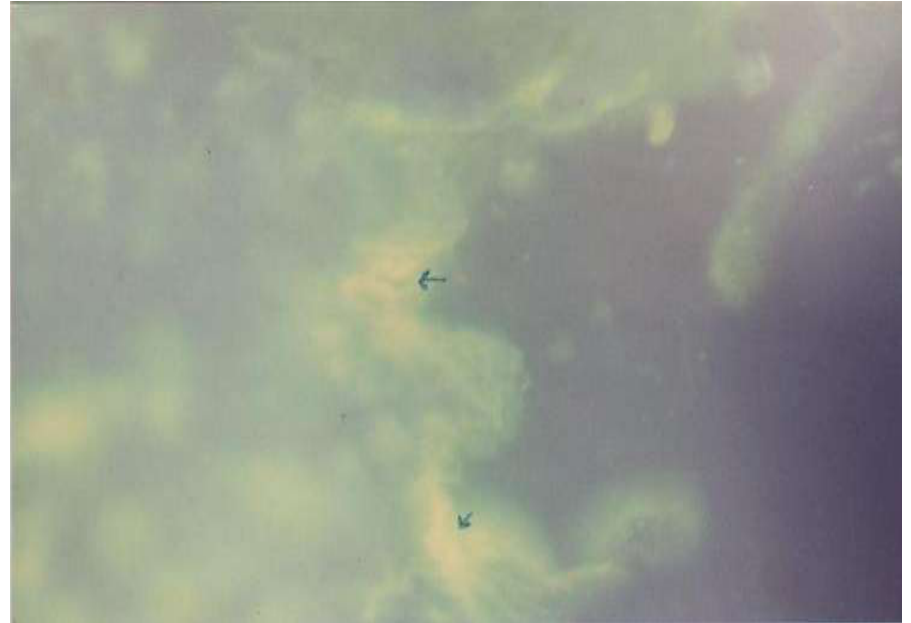
Fig. (1): Ileum of the calf sacrificed 8 hours (PI), showing salmonella in the